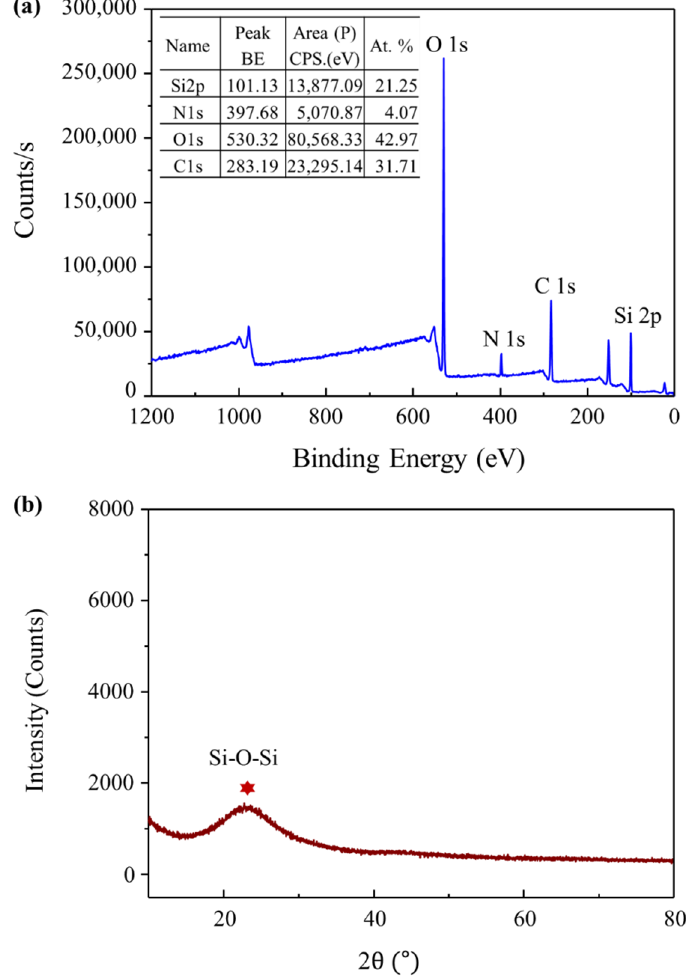
Figure 4. ( a ) XPS and ( b ) XRD analyses confirm the chemical component formation rate in the NCs.